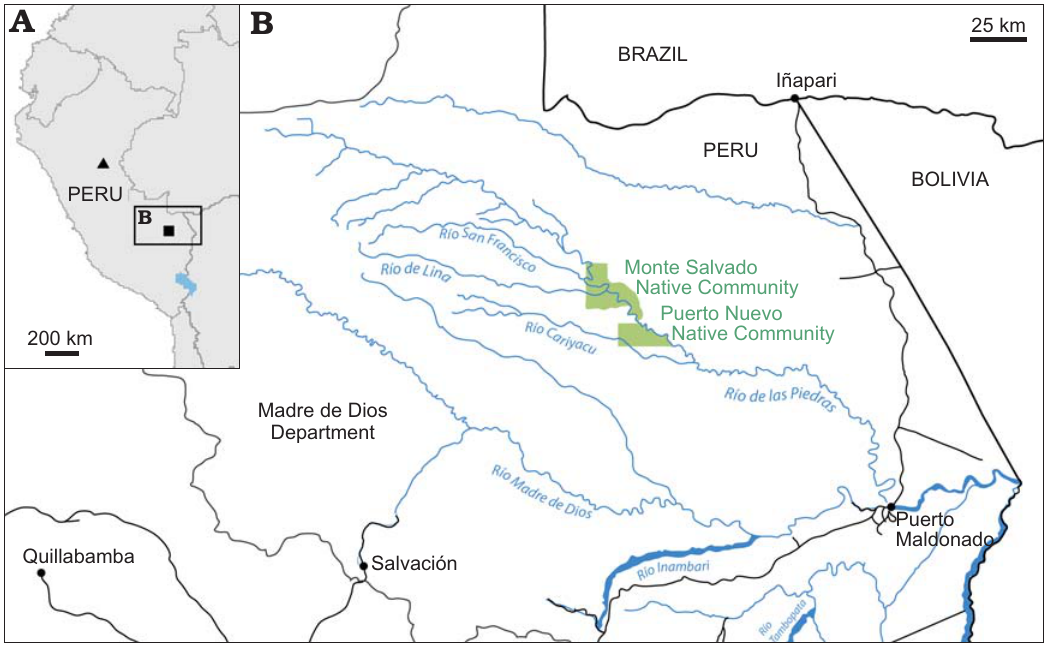
Fig. 1. A . General map of Peru showing geographic location of Phoberomys -yielding localities: Monte Salvado, Madre de Dios Department (square) and Pisqui River, Nuevo Edén area, Loreto Department (triangle). B . Location map of the Monte Salvado Native Community area in Peruvian Amazonia, where the fragmentary left mandible MHNC-MS-001 was found. Based on data from the Instituto Geográfico Nacional del